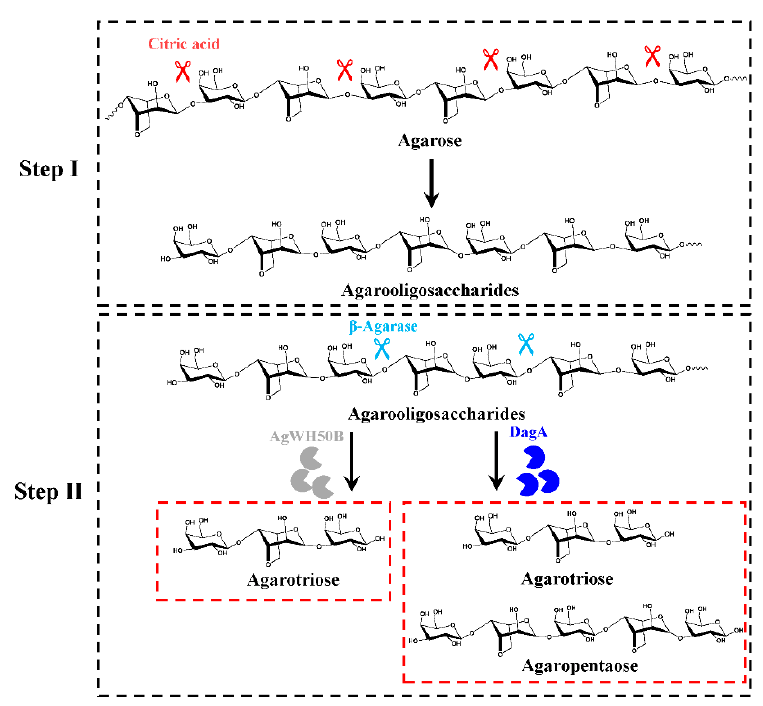
Figure 1. Technical route for preparation of A3 or both A3 and A5 by acid hydrolysis followed by enzymatic hydrolysis.